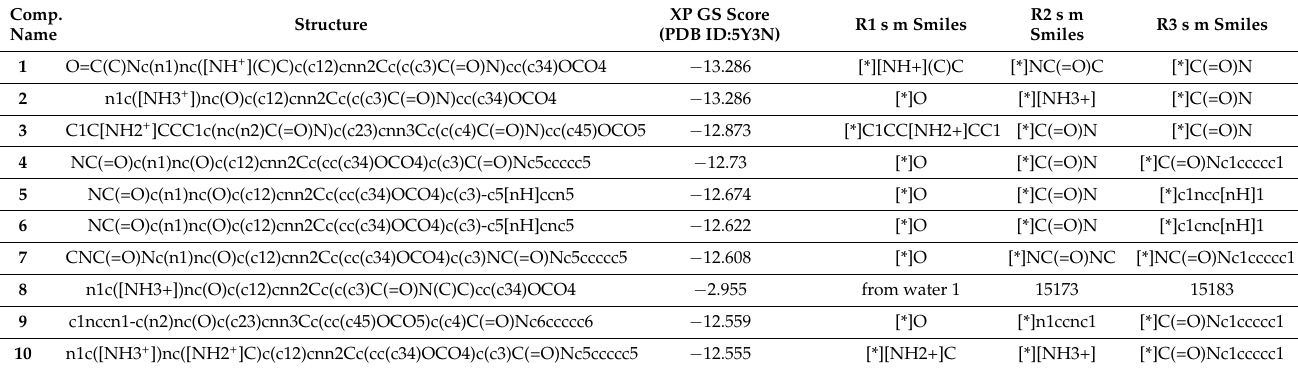
Table 10. R group determination by enumeration study using the Schrödinger